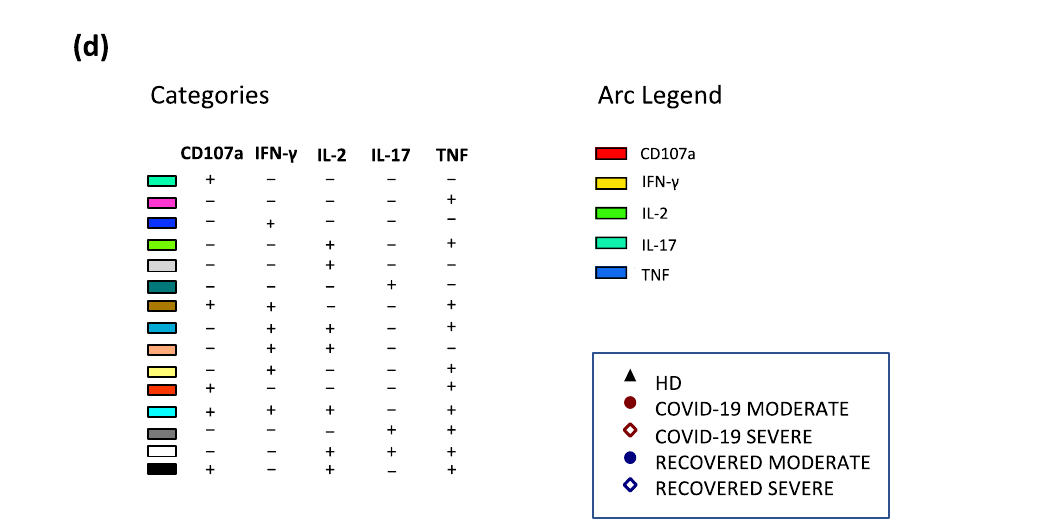
Figure 3. Polyfunctionality of CD4+ T cells after in vitro stimulation. Pie charts representing the proportion of CD4+ T cells producing different combinations of IFN- γ TNF, IL-2, IL-17, GRZB as well as expressing CD107a after stimulation with ( a ) M; ( b ) N; or ( c ) S peptide pools from HD ( n = 10), COVID-19 moderate ( n = 7), COVID-19 severe ( n = 6), recovered moderate ( n = 9) and recovered severe ( n = 6) patients. For clarity, panel ( d ) reports the legend for the colors and the symbols used in panels ( a – c ). Data in pie charts are represented as median values. Frequencies were corrected by background subtraction as determined in non-stimulated controls using SPICE software. Statistical analysis between pie charts was performed using permutation test (* p < 0.05; ** p < 0.01; *** p < 0.001). Pie arches represent the total production of different cytokines. Comparison between the production of different combinations of cytokines by CD4+ T cells is represented. Data are represented as individual values, mean (center bar) ± standard error of the mean (SEM, upper and lower bars) is represented. Statistical analysis was performed using Kruskal–Wallis non-parametric test corrected for multiple comparisons by controlling the False Discovery Rate (FDR), method of Benjamini and Hochberg. * q < 0.05; ** q < 0.01; *** q < 0.001.